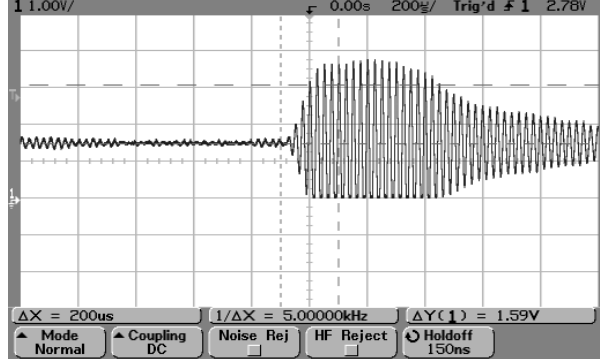
Figure 21. Zoom of pulse